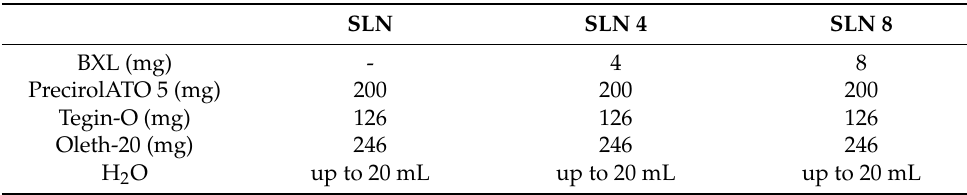
Table 1. Composition of unloaded and BXL-loaded